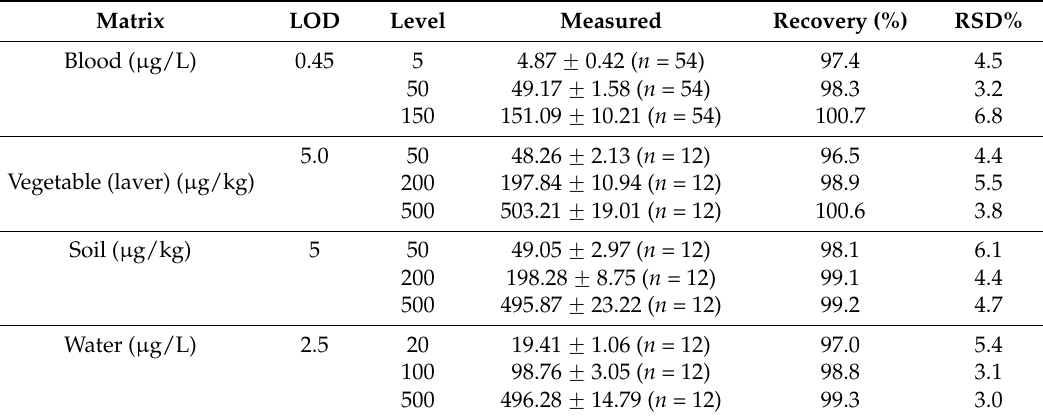
Table 2. Methodology